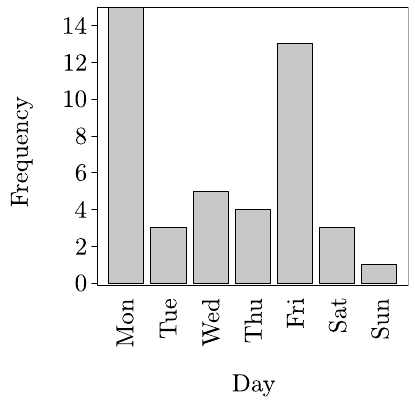
Figure 8: Daily frequency of occurrence of